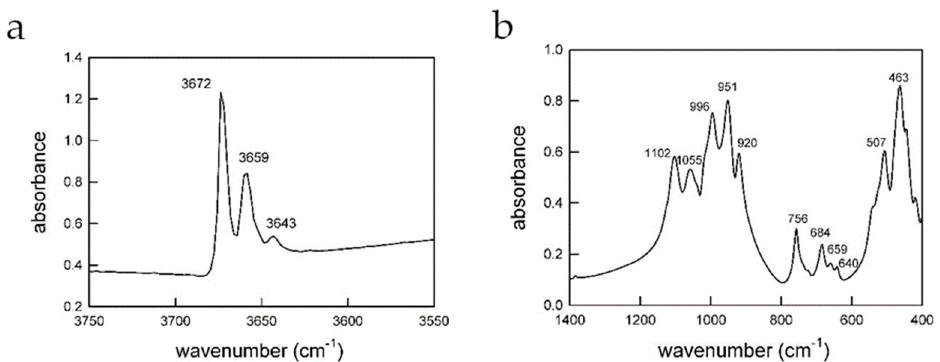
Figure 5. ( a ) OH-stretching and ( b ) lattice mode region Fourier-transform Infrared Spectroscopy (FTIR) spectrum of the tremolitic amphibole powder from Passo di Caldenno, Italy.